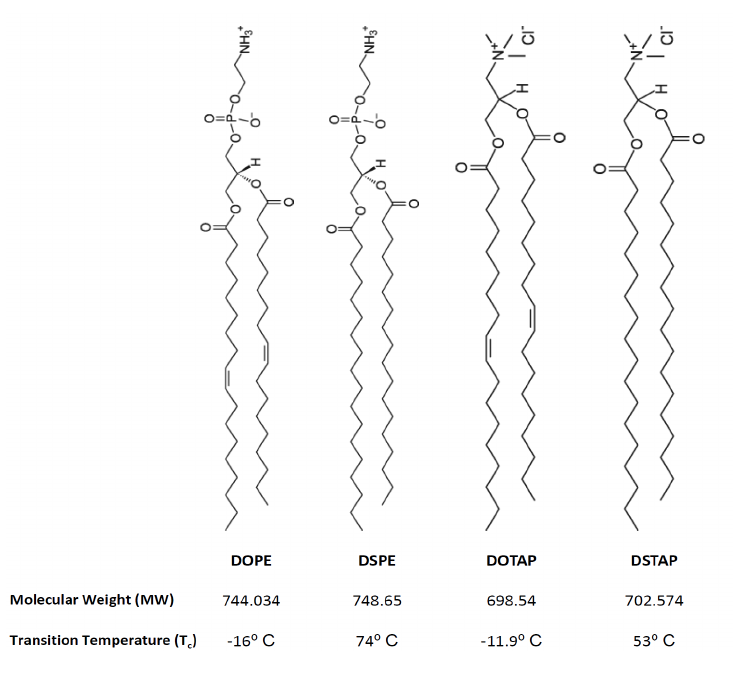
Figure 1. Molecular structure of DOPE and DSPE and the cationic lipids DOTAP and DSTAP used.